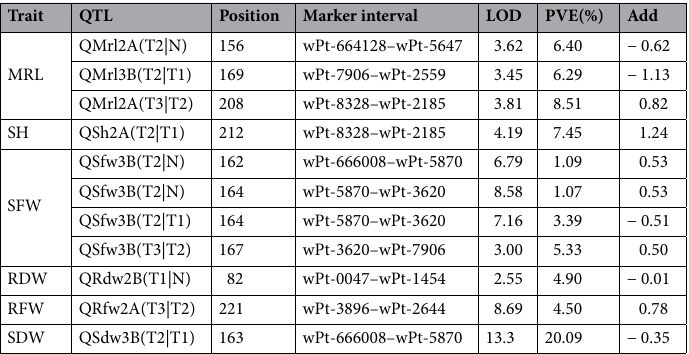
Table 5. Additive effects of conditional QTLs in the RIL